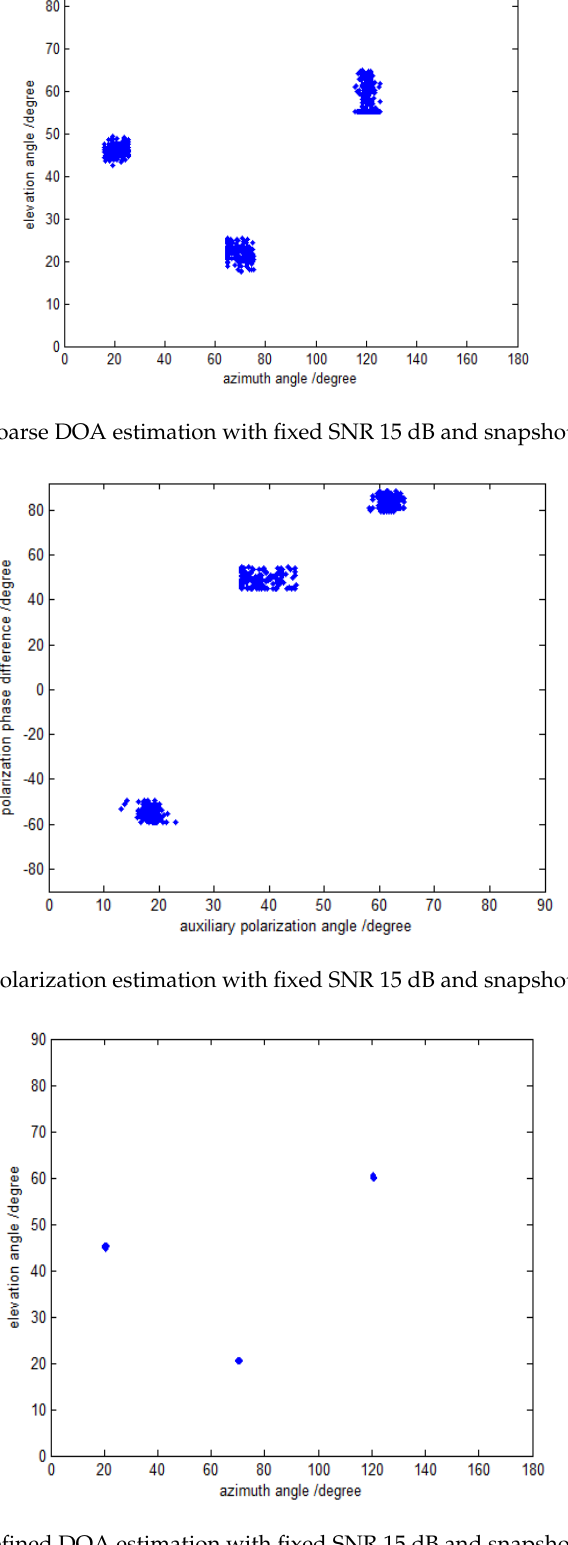
Figure 4. The refined DOA estimation with fixed SNR 15 dB and snapshot number 500.